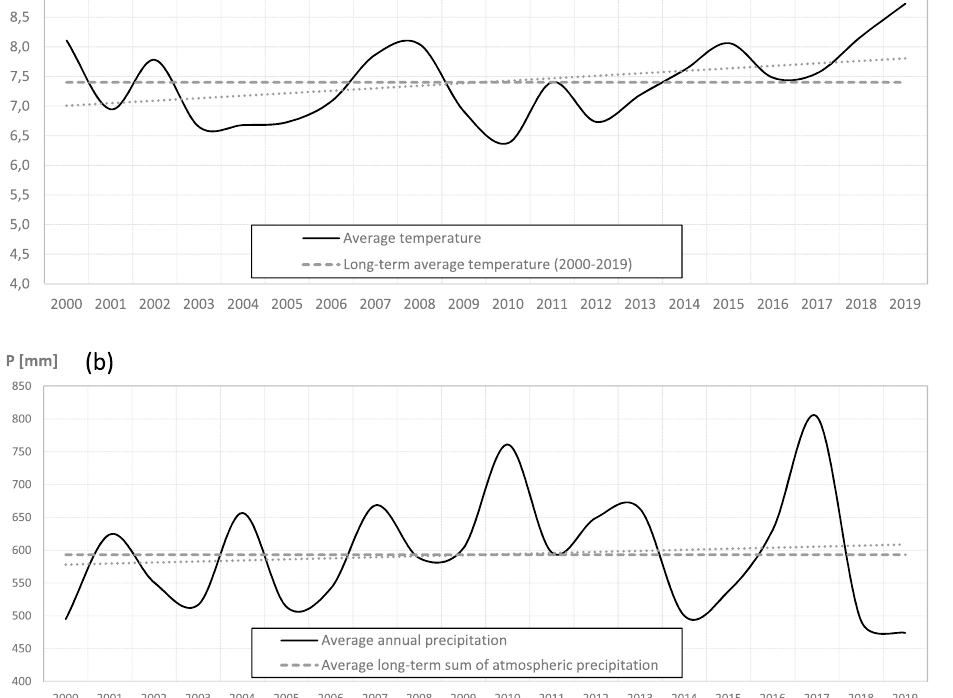
Figure 4. Variation in the mean annual temperature ( a ) and mean annual precipitation ( b ) in the study area in